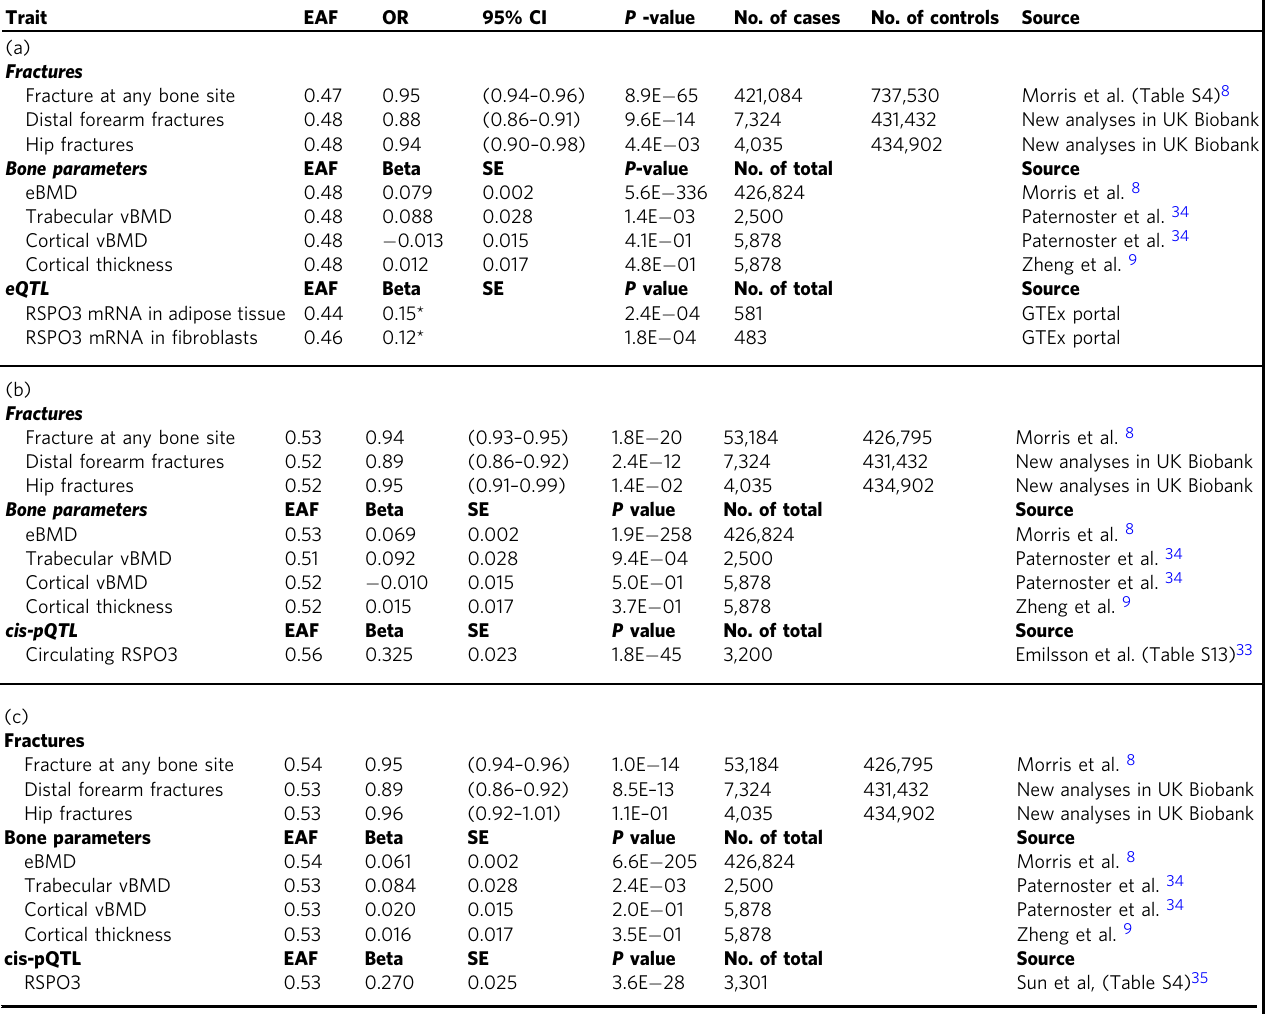
Table 1 (a) Associations for rs7741021 in the RSPO3 locus (C-allele = effect allele). (b) Associations for rs3734626 in the RSPO3 locus (T-allele = effect allele). (c) Associations for rs2489623 in the RSPO3 locus (C-allele = effect